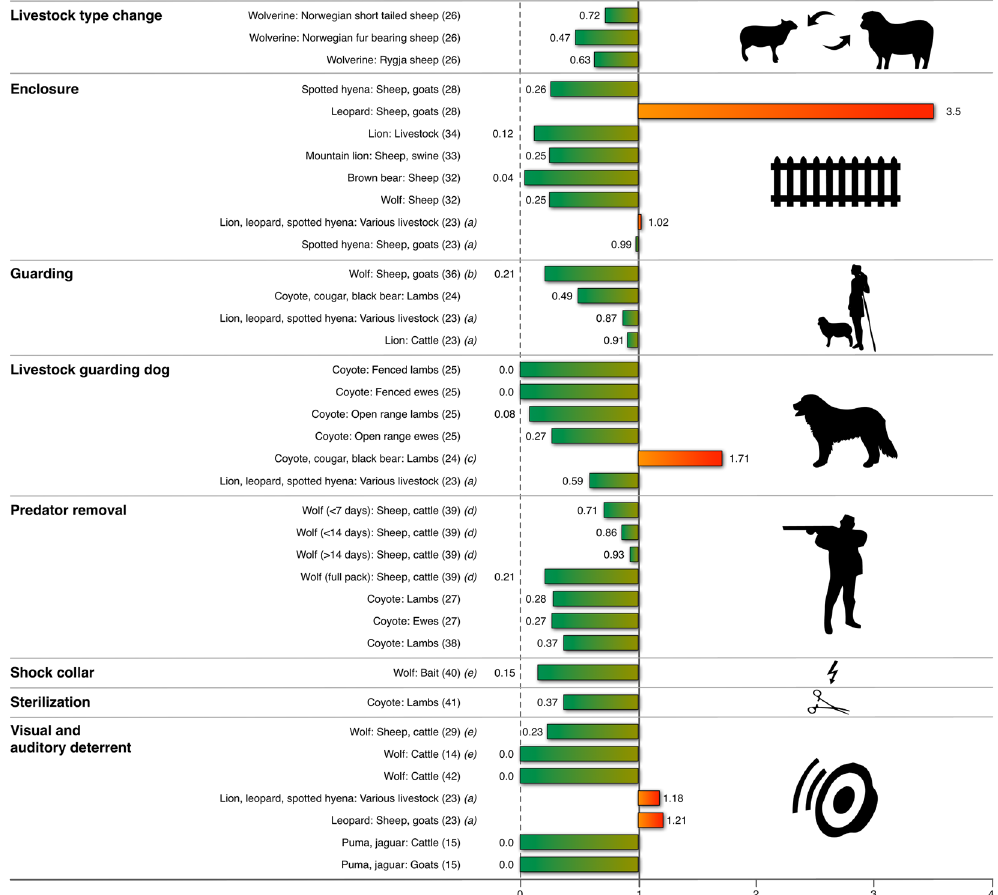
Figure 1. The intervention effectiveness described as relative risk (RR) for each study. RR = 1 suggests no difference in the risk of carnivore attack between treatment and control groups. RR > 1 suggests there is a higher risk of carnivore attack in the treatment group, and the value can be infinitely large. RR < 1 suggests that there is a lower risk of carnivore attack in the treatment group, and the minimum possible value is 0 (no attack in the treatment group). Each row in the figure represents a study or sub-study of an intervention in a certain setting, with the carnivore species and type of livestock described in the figure. Reference to the original publication is written in brackets. For more information of each study please refer to Supplementary Table S1. Additional information for particular studies: ( a ) For Woodroffe et al . 23 , odds-ratios were converted to RR using an online Odds Ratio to Risk Ratio calculator 64 . ( b ) Iliopoulos et al . 36 measure severity of the wolf attack once it has occurred. ( c ) Palmer et al . 24 b state that the treatment herd was divided into two bands, and all losses occurred in the band without the livestock guarding dog. ( d ) For Bradley et al . 39 we report hazard ratio HR (1850 days) from the original study. ( e ) Hawley et al . 40 , Davidson-Nelson & Gehring 29 , and Lance et al . 14 measure trespass rate into baited areas instead of livestock